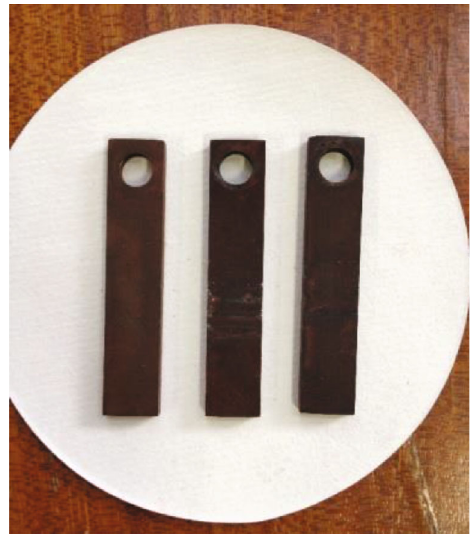
Figure 4: Coupon after